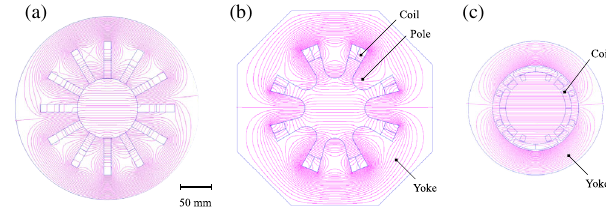
FIG. 1. Rotating magnetic field generated by DW-SCM (a) current phase θ ¼ 0 °, (b) θ ¼ 45 °.